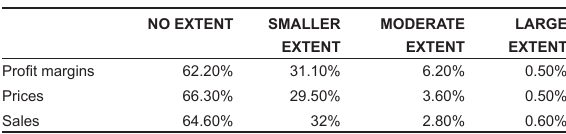
TABLE 18 The negative impact of HIV/AIDS on profit margins, prices and sales (% of respondents)